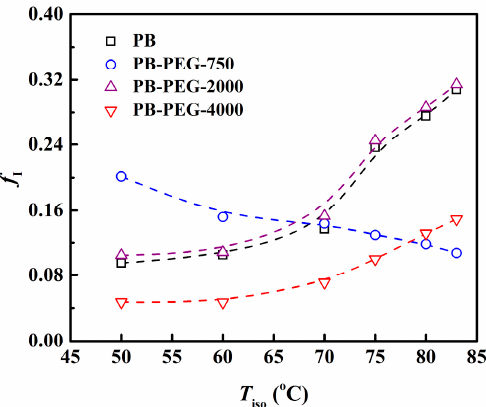
Figure 8. Fraction of transformed form I ( f I ) in the PB and PEG-grafted copolymers as a function of isothermal crystallization temperature. The thermal protocol is illustrated in Figure S3c.